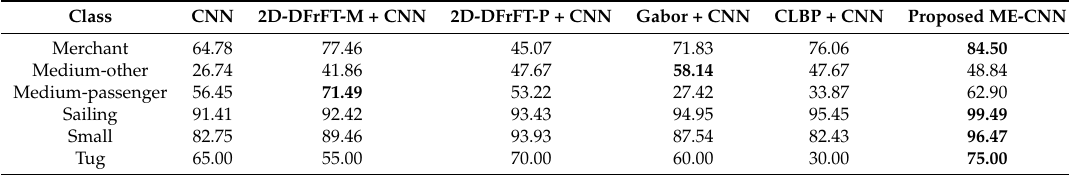
Table 10. Class-specific accuracy (%) for the VAIS